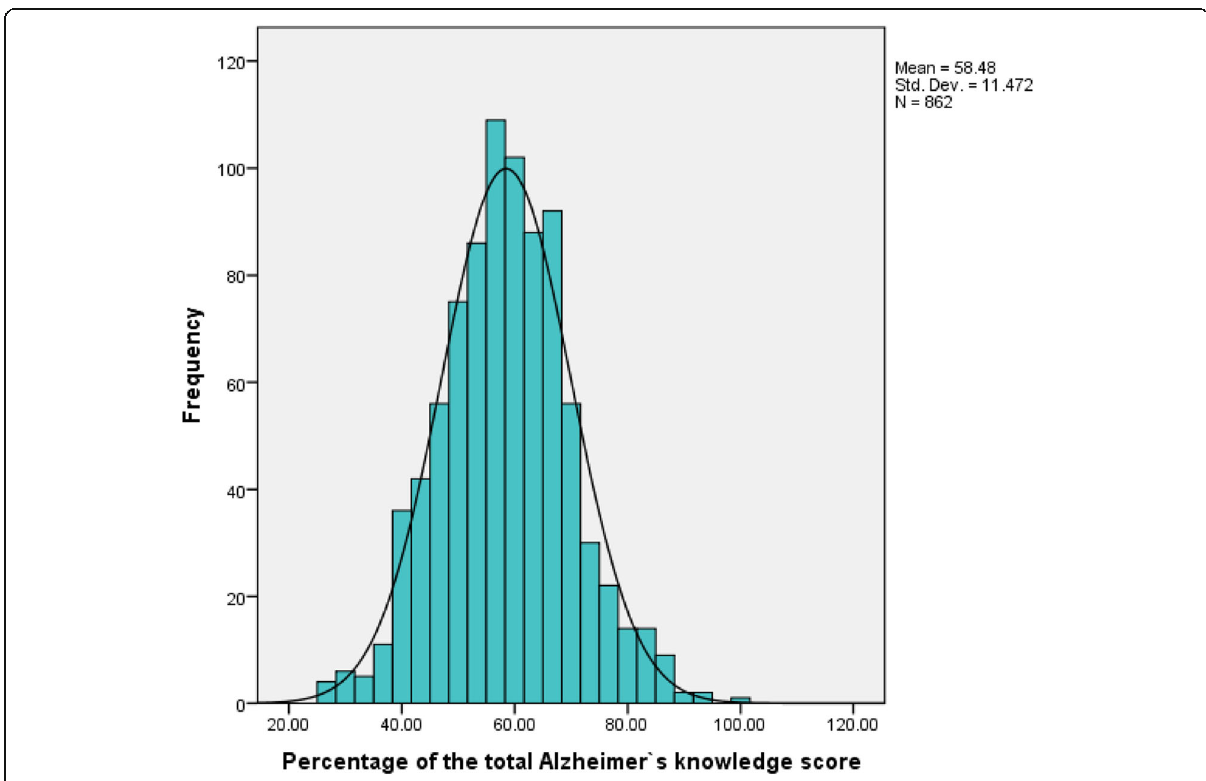
Fig. 2 Distribution of the percentage of the total Alzheimer ’ s knowledge score among the